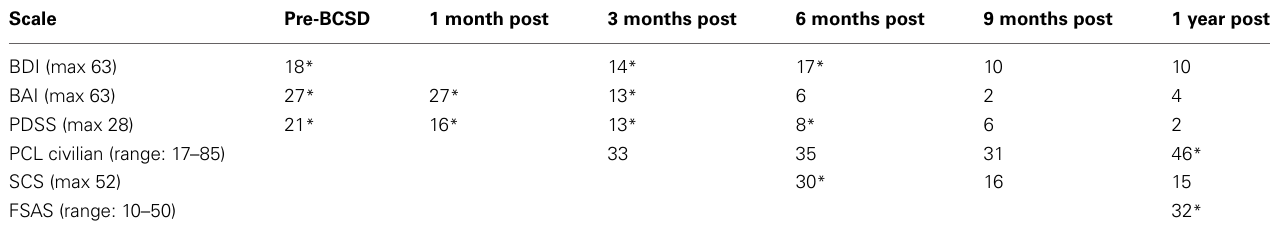
Table 1 | Psychiatric symptom ratings for Case 1 during 1 year